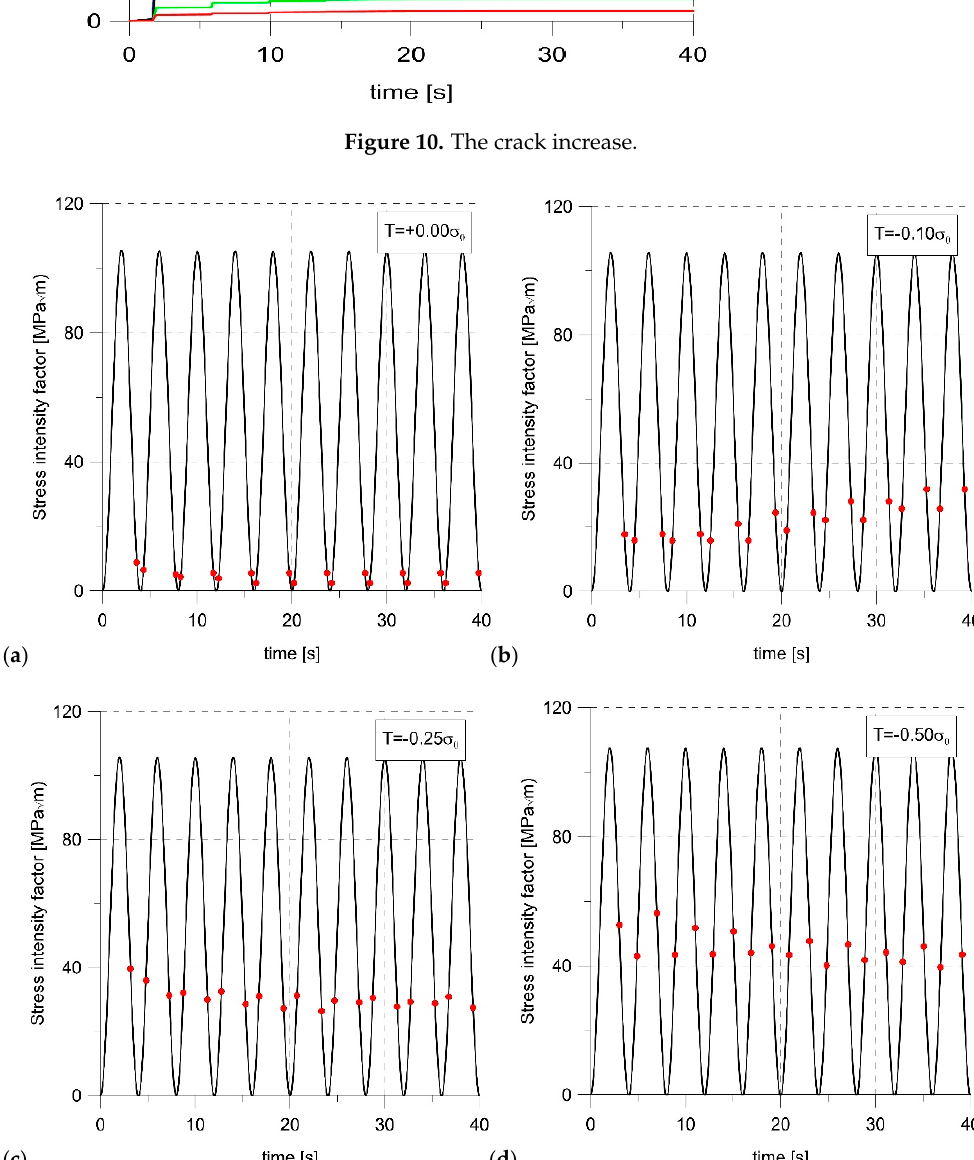
Figure 11. The stress intensity factor (SIF) opening values for subsequent loading cycles for: T = +0.25 σ 0 ( a ), T = +0.00 σ 0 ( b ), T = − 0.50 σ 0 ( c ), and T = − 0.75 σ 0 ( d ).